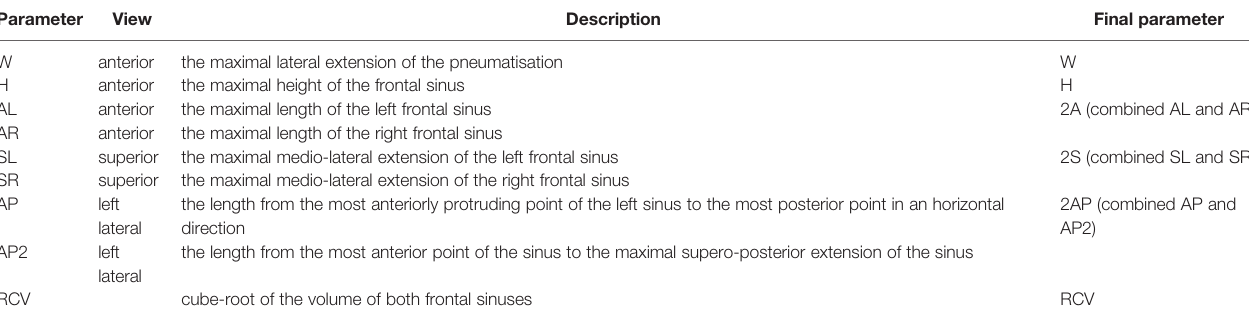
TABLE 1 | Description of the measurements of the frontal sinuses in 3D. Parameter